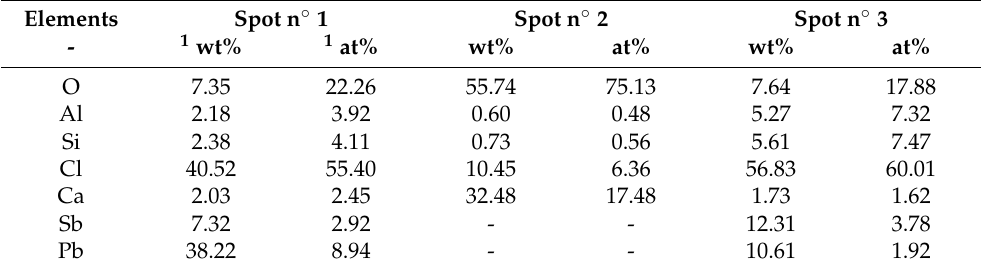
Table 1. Elemental composition of W-PVC analyzed by SEM-EDS.